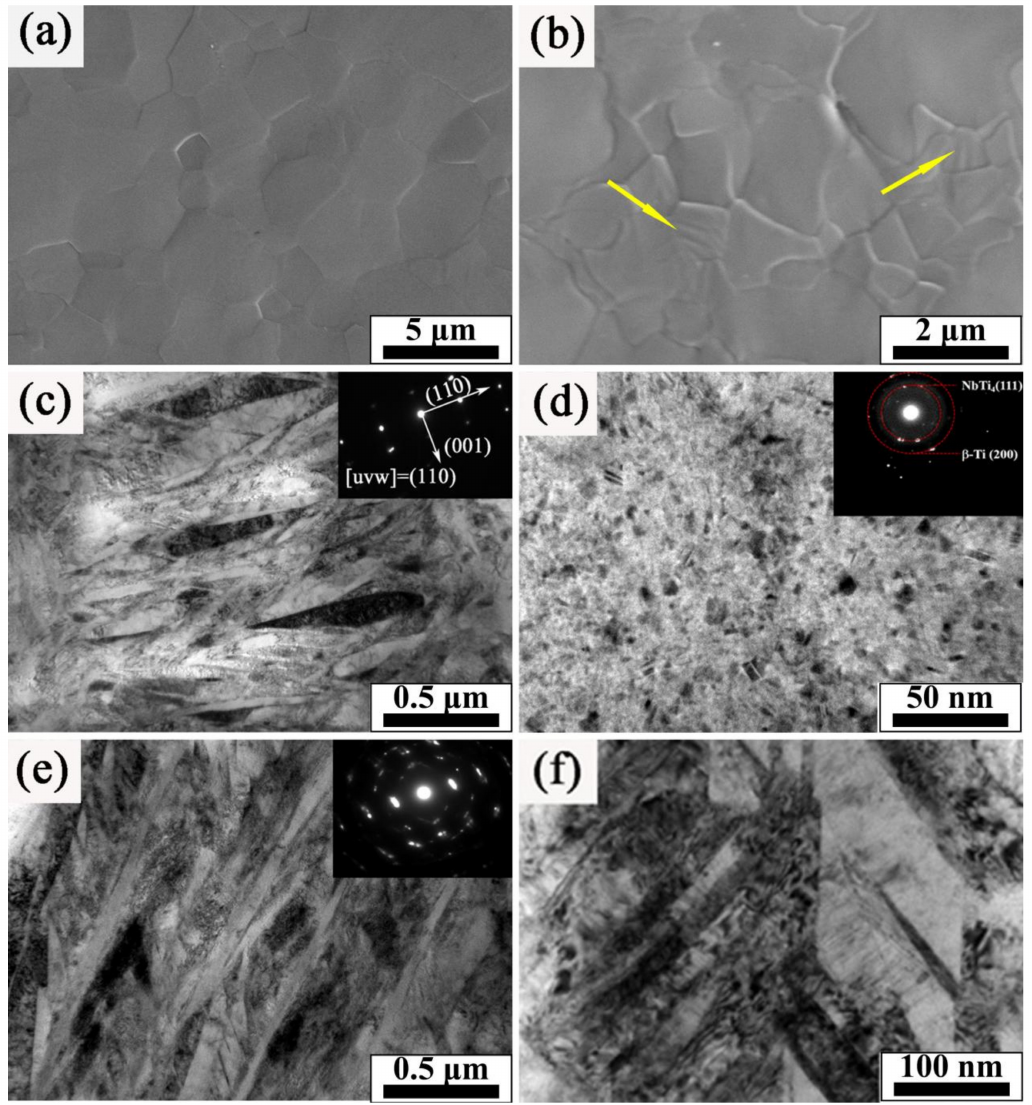
Figure 5. ( a , b ) SEM images, ( c – f ) TEM images and SAED patterns of the Nb-alloyed sample surface after 40-pulsed